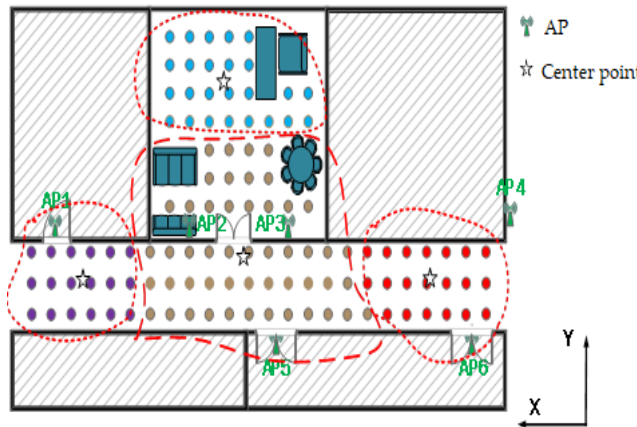
Figure 7. The number of clusters L and the corresponding BWP results.